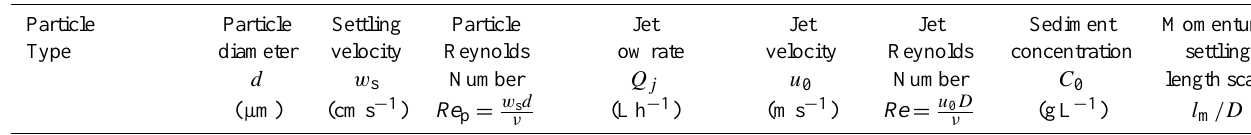
Table 1. Summary of horizontal sediment-laden jet experiments for bottom deposition and cross-sectional sediment concentration